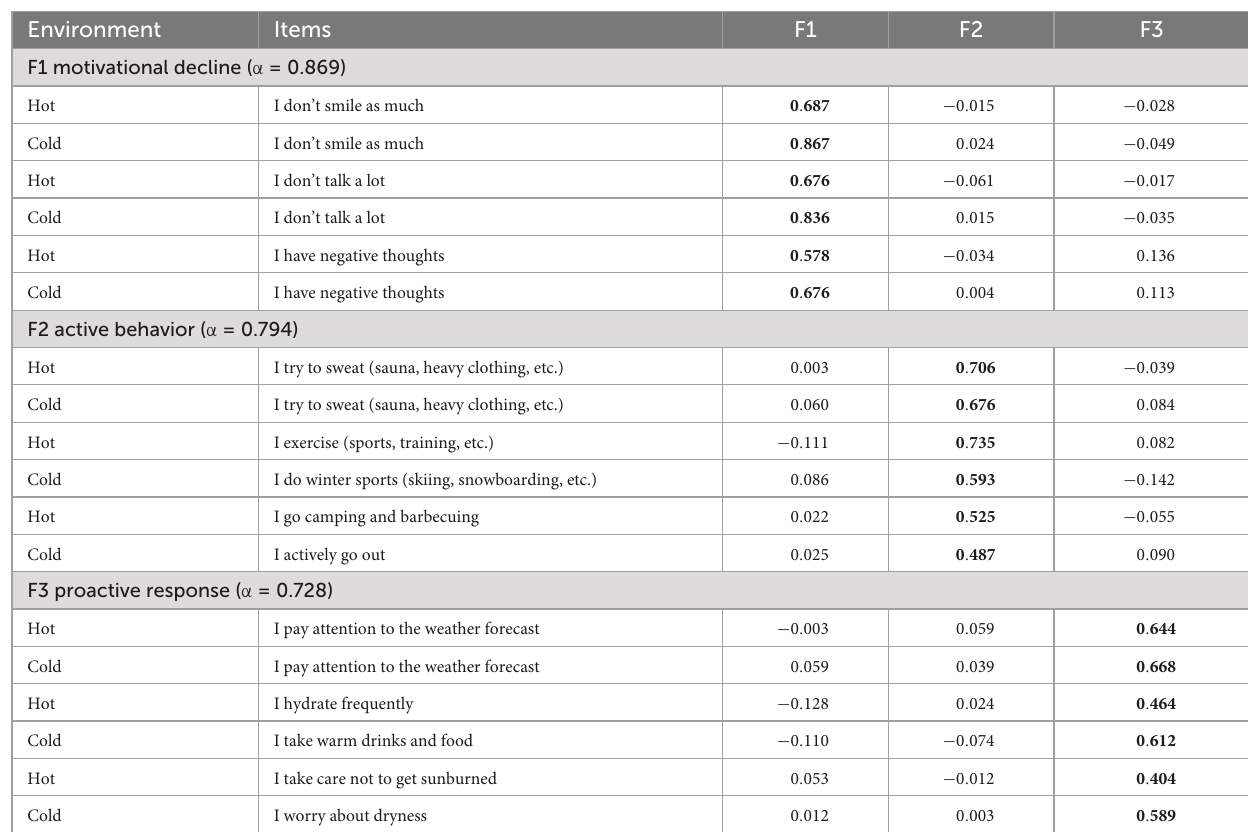
TABLE 1 Results of factor